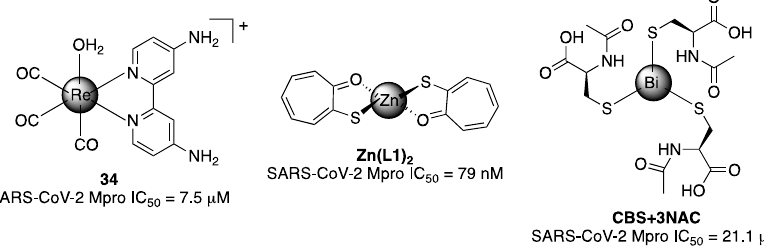
Figure 21. Metal complexes as inhibitors of SARS ‐ CoV ‐ 2 main protease.